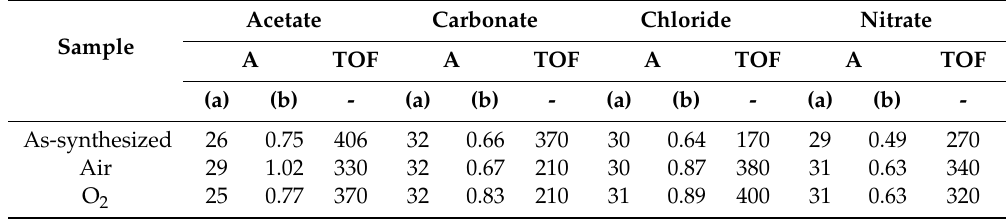
Table 6. Impacts of the precursors and of the treatment in air and in O 2 of di ff erent MgF 2 samples after HF activation on the transformation of 2-chloropyridine (T = 350 ◦ C, HF / 2chloropyridine / N2: 7 / 1 / 1.7, isoconversion around 30%). A: Activity for the transformation of 2-chloropyridine: (a) mmol.h − 1 · g − 1